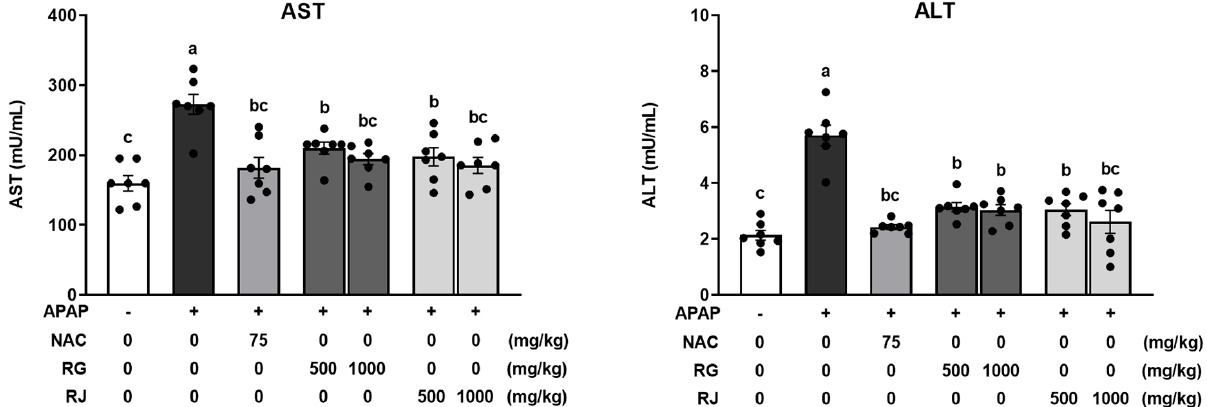
Figure 2. Effects of radish extracts on plasma alanine aminotransferase (ALT) and aspartate transaminase (AST) activity in APAP-induced liver-damaged mice. Results are presented as means ± SE. Different letters represent groups that are significantly different from each other using ANOVA at p < 0.05 ( n = 7). Each dot indicates data measurement for one mouse. CTRL, control; NAC, N-acetyl cysteine; RG, turnips of Ganghwa; RJ, radishes of Jeju.